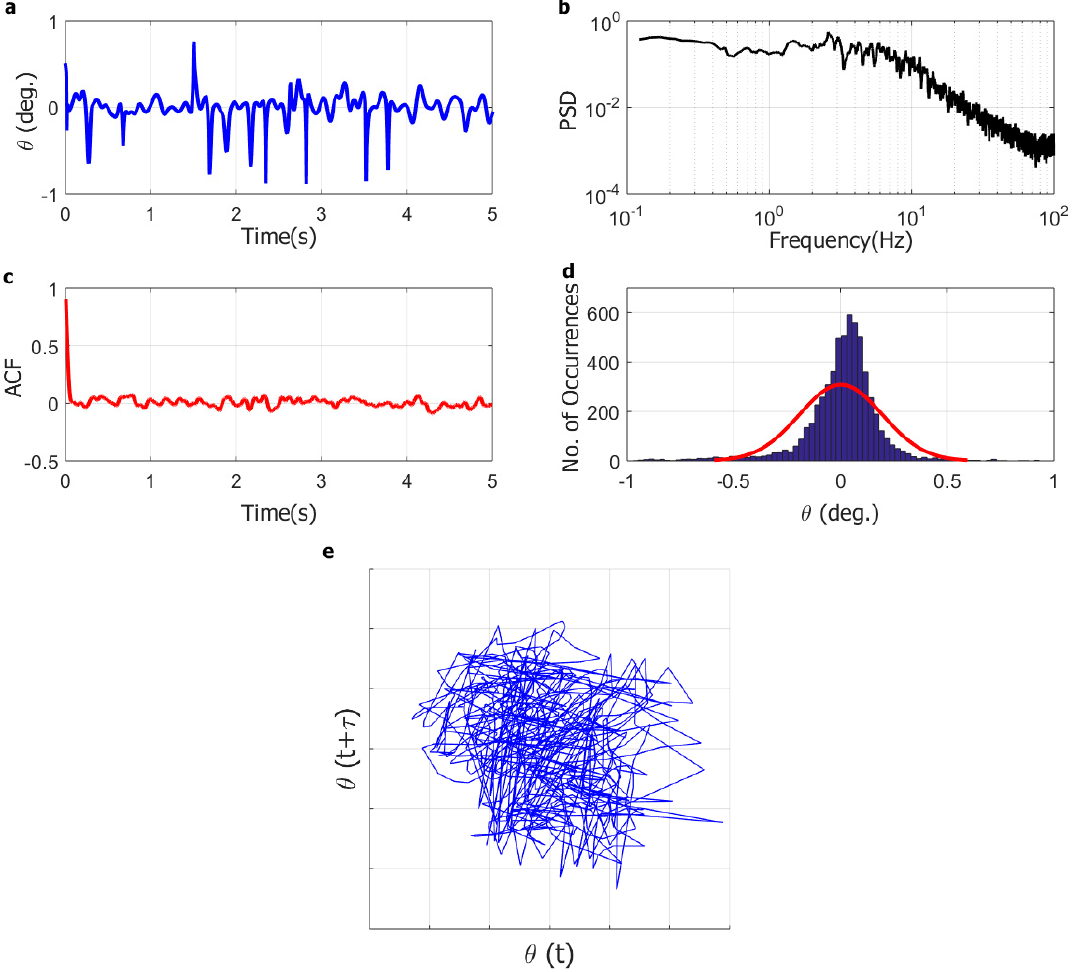
Figure 5. Representative dynamics of aligned-vibrating regime for the full-solar flag at wind speed of 4.7 m / s: ( a ) angular position time series (5 s); ( b ) angular position power spectral density (PSD); ( c ) angular position autocorrelation function (ACF); ( d ) angular position histogram; ( e ) system trajectory in phase-space (reconstructed attractor).